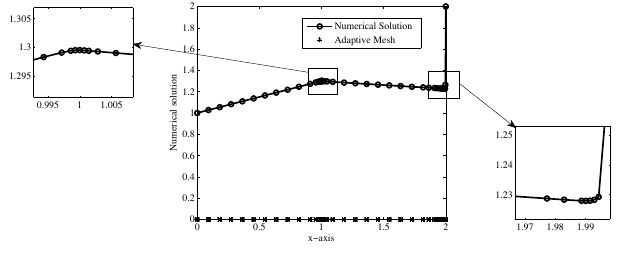
Figure 3. Numerical solution for Example 3 with ε = 2 − 8 , N = 23 (initially)